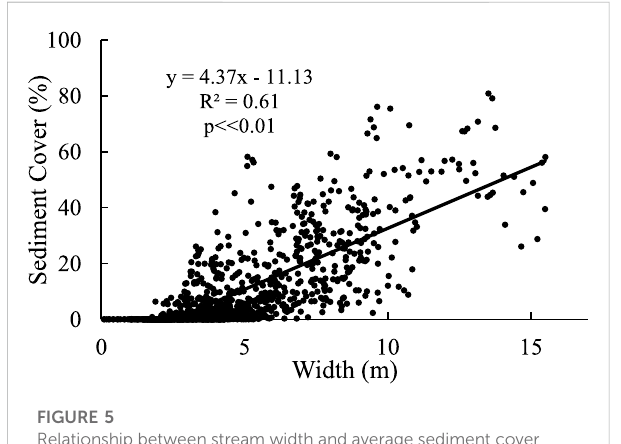
FIGURE 6 Box plot of incoming solar radiation for sediment in the stream (right) and outside of the stream (left). The difference in the average values of the two distributions was 14 Wm − 2 . This is equivalent to an increase in incoming solar radiation of 7.8% for sediment in the stream.